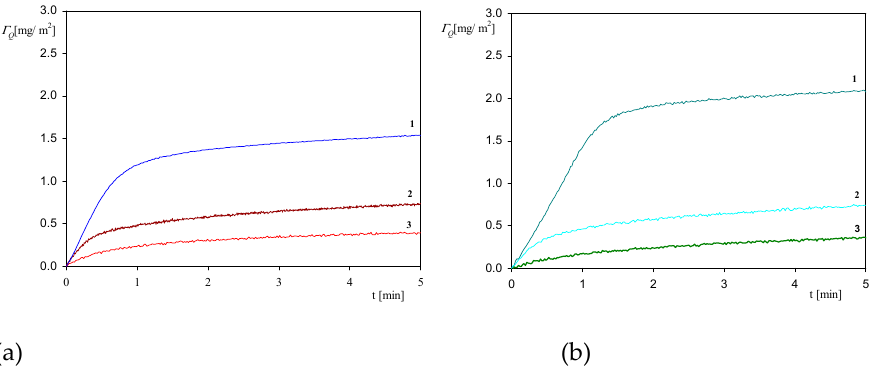
Figure 9. The kinetics of myoglobin adsorption on the silica sensor determined by QCM, flow rate 2.5 × 10 − 3 cm 3 s − 1 , bulk protein concentration equal to 10 mg L − 1 . Part ( a ); ionic strength 0.01 M, 1. pH 3.5, 2. pH 5.5, 3. pH 7.4. Part ( b ); ionic strength 0.15 M, 1. pH 3.5, 2. pH 5.5, 3. pH